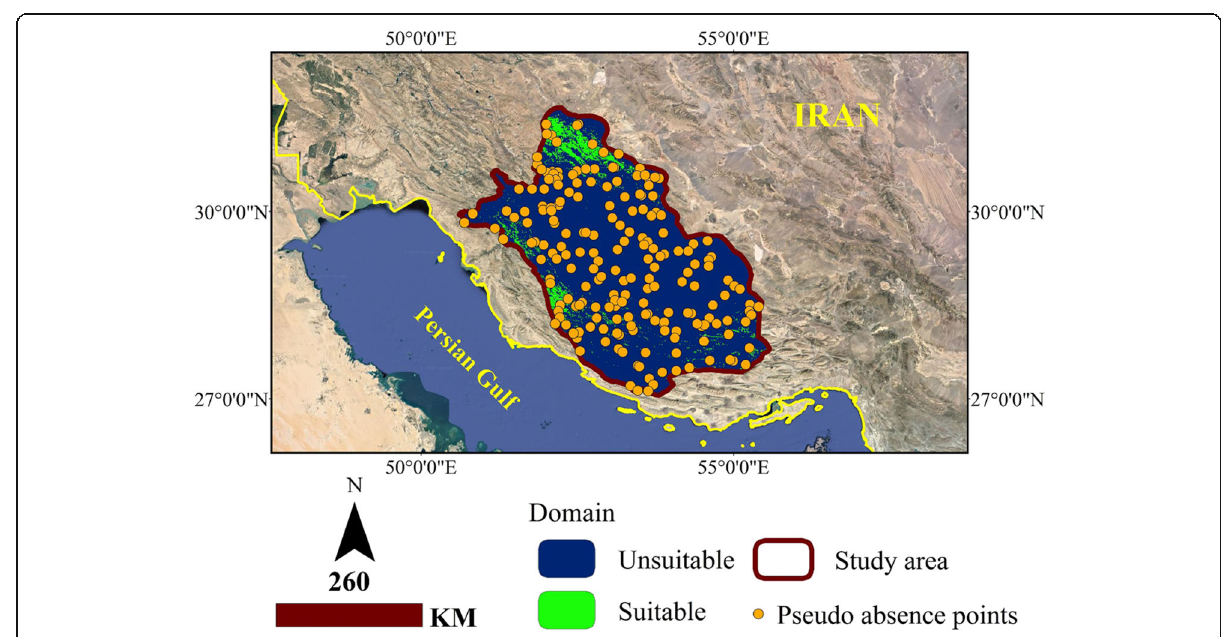
Fig. 2 Result of DOMAIN present only model and location of pseudo-absence points